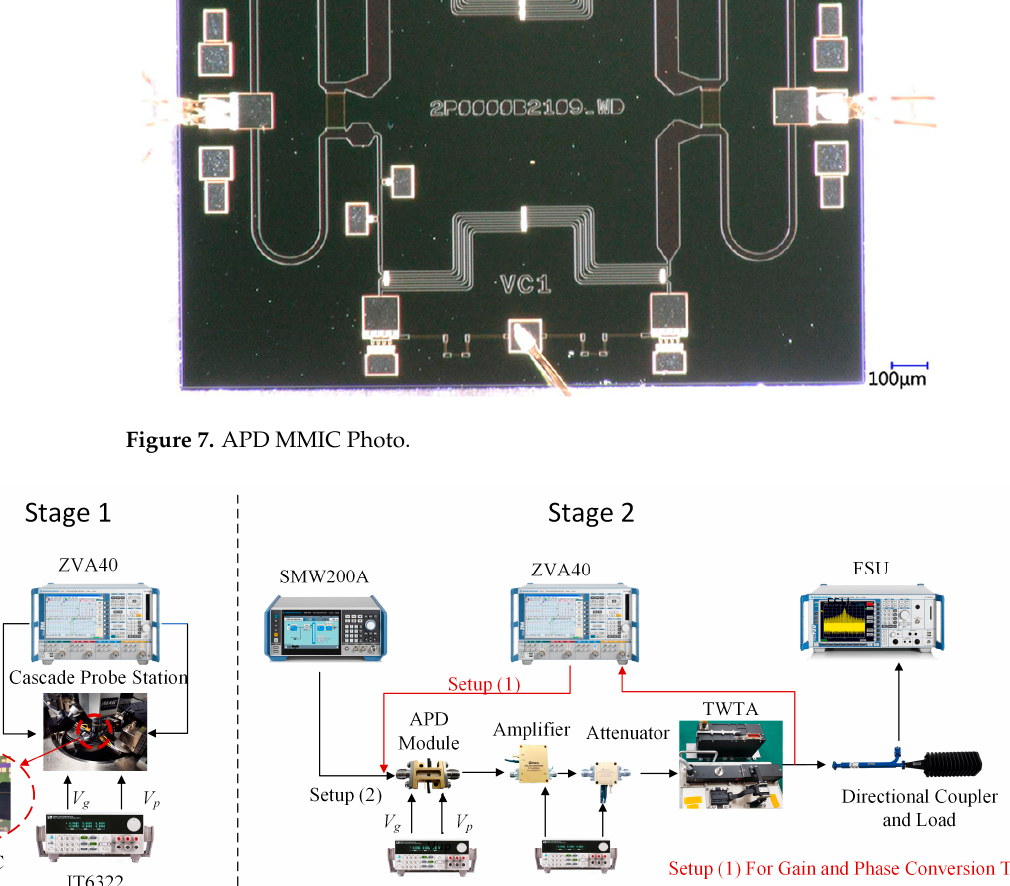
Figure 8. The test platform for APD MMIC and TWTA cascade with proposed APD MMIC.